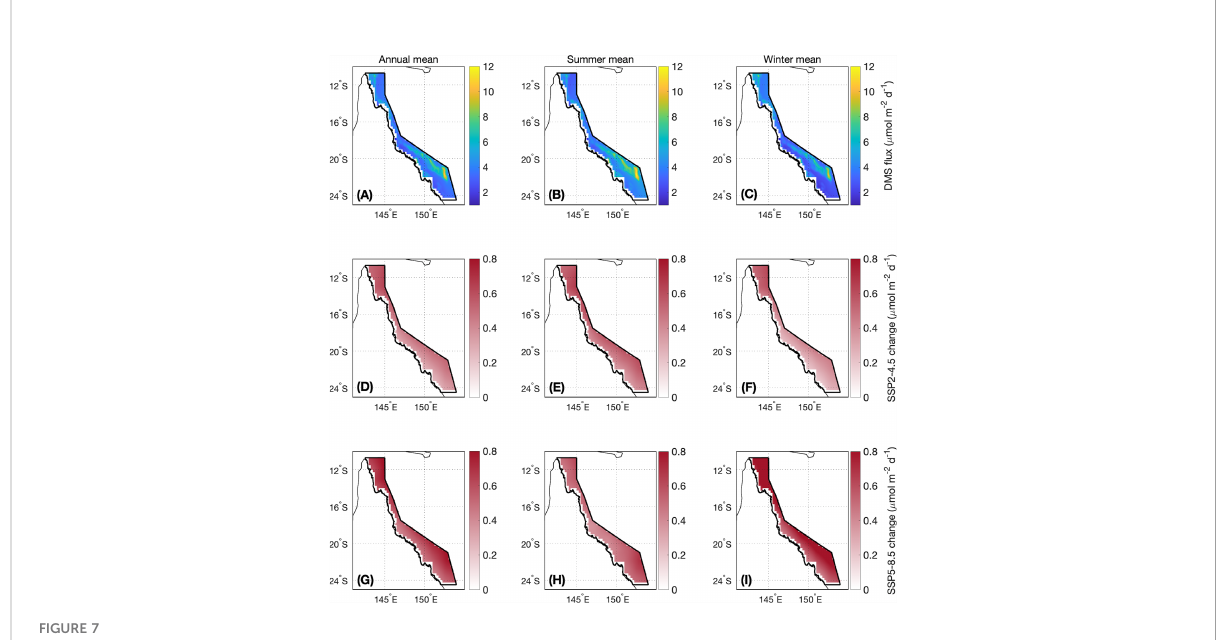
FIGURE 7 As for Figure 5, but for DMS fl